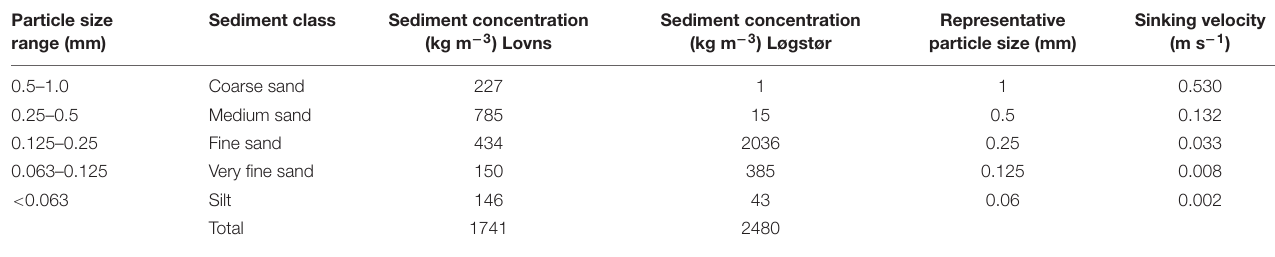
TABLE 2 | Sediment composition in Lovns Bredning and Løgstør Bredning showing particle size range (mm), sediment class, sediment concentrations (kg m − 3 ) at 0–1 cm depth (Lovns) and 0–2 cm depth (Løgstør), and representative particle size applied in the estimated sinking rates. Particle size range